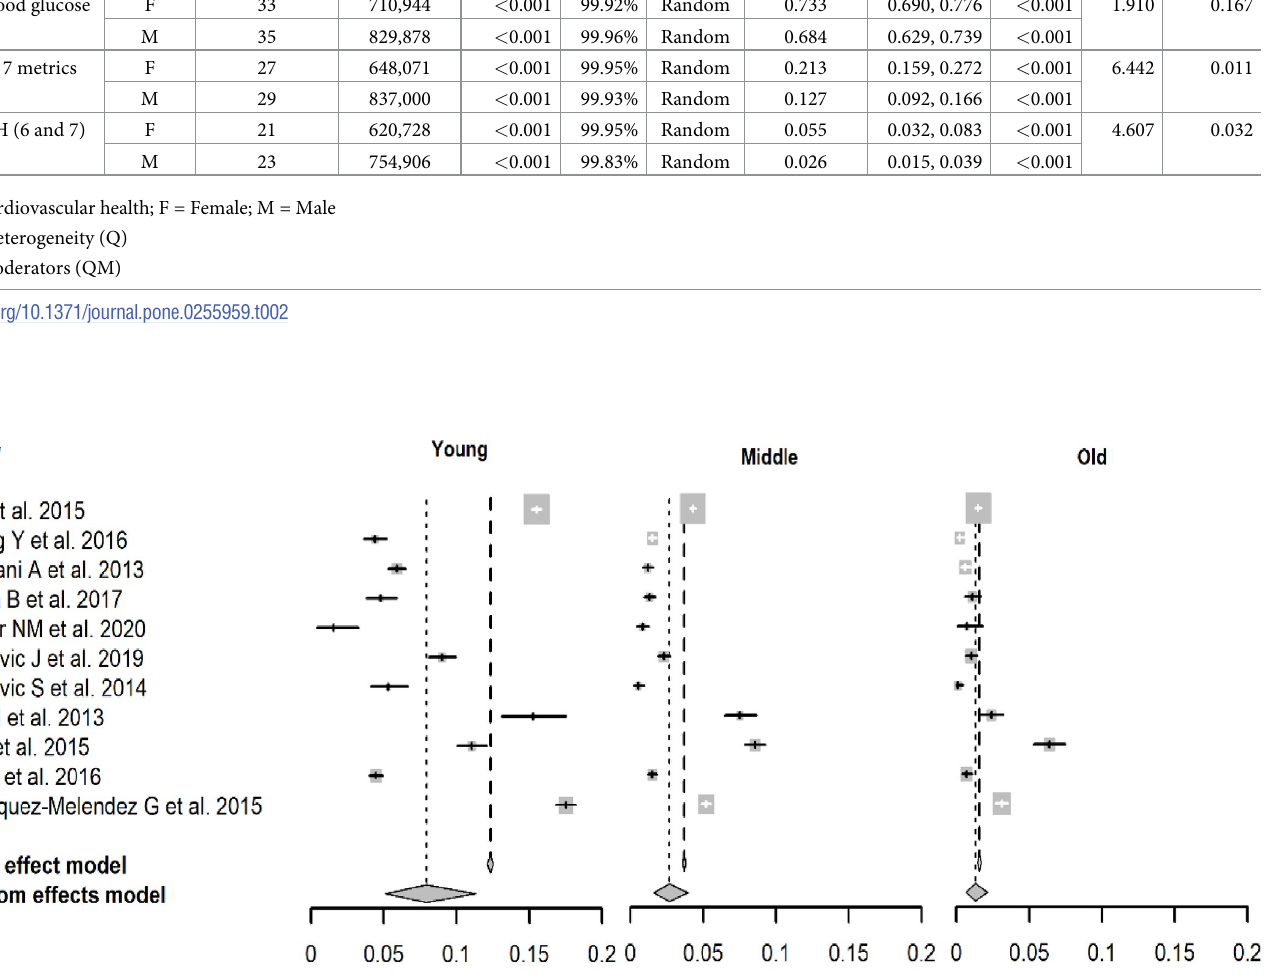
PLOS ONE | https://doi.org/10.1371/journal.pone.0255959 August 11,